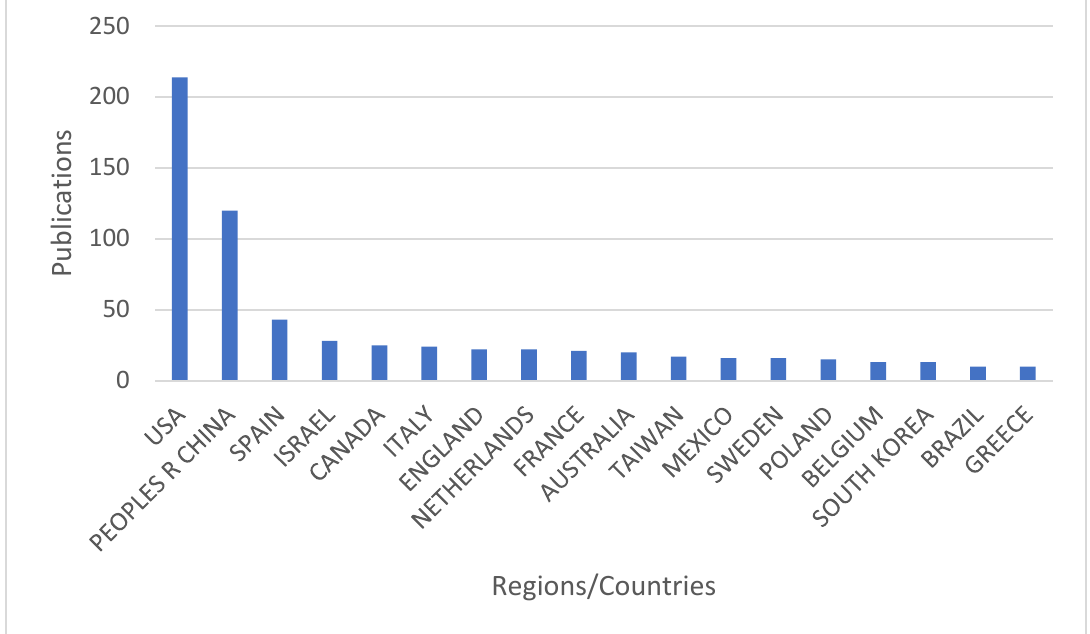
Figure 3. Annual distribution of prenatal exposure to air pollution publications by countries and territories.